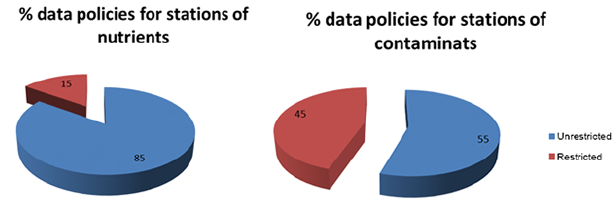
Figure 3. Data policy for nutrients and contaminant